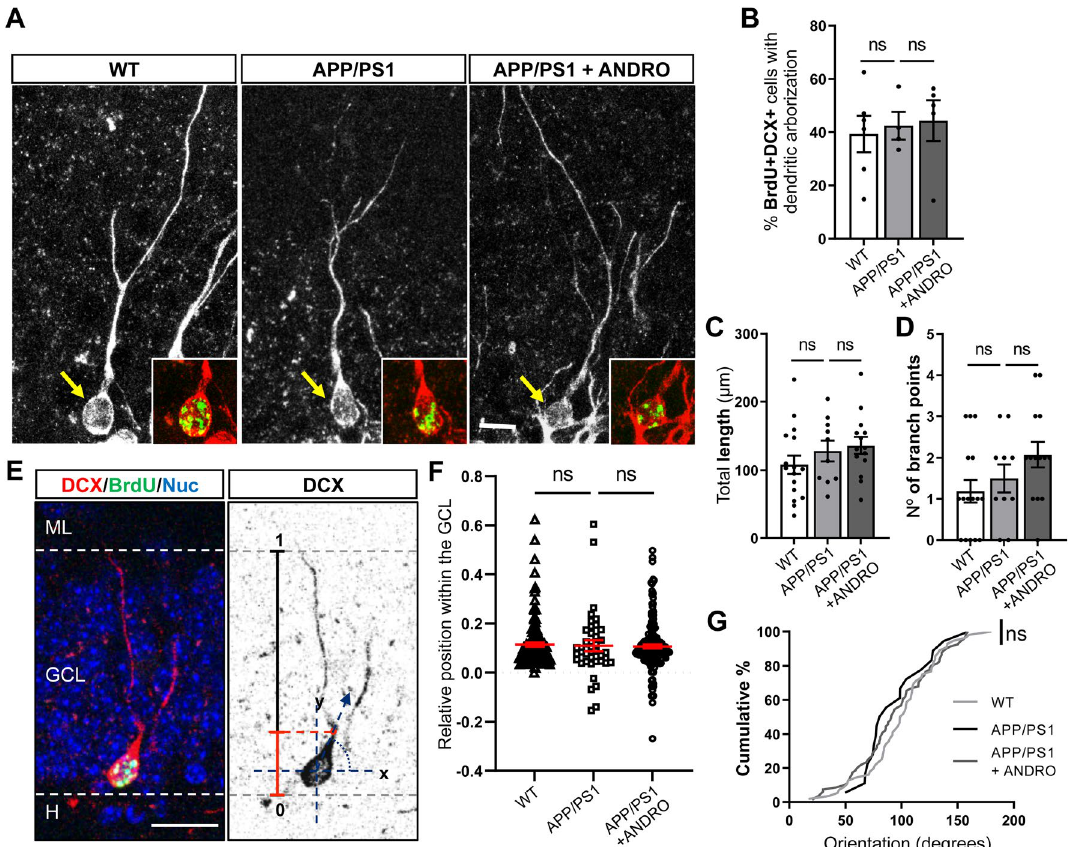
Figure 4. ANDRO does not affect early morphological development of newborn neurons. ( A ) Representative confocal images of BrdU+DCX+ cells showing dendritic arborization into the GCL towards the molecular layer in control wild-type (WT), APPswe/PSEN1ΔE9 (APP/PS1) mice, and APP/PS1 mice treated with ANDRO. Images correspond to maximal projection of 10 µm z-stack. Insets show z-stack of BrdU+DCX+ staining in cells indicated with the arrows (DCX: red; BrdU: green). Scale Bar: 10 µm ( B ) Quantification of the percentage of BrdU+DCX+ cells extending dendrites toward the molecular layer in WT, APP/PS1 mice and APP/PS1 mice treated with ANDRO. Data are presented as mean ± SEM; WT = 6 mice; APP/PS1 = 4 mice; APP/PS1 + ANDRO = 5 mice. ns, non-significantly different; one-way ANOVA test followed by Bonferroni post-hoc test. ( C , D ) Quantification of the total dendritic length ( C ) and number of branch points ( D ) of BrdU+DCX+ cells in WT, APP/PS1 and APP/PS1 mice treated with ANDRO. Data are presented as mean ± SEM; WT = 16 cells (N = 3 mice); APP/PS1 = 10 cells (N = 3 mice); APP/PS1 + ANDRO = 14 cells (N = 3 mice). One-way ANOVA test followed by Bonferroni post-hoc test. ns, non-significant. ( E ) Representative immunofluorescence of BrdU+DCX+ cell (left panel) and inverted DCX immunostaining (right panel) showing the schematic model of the analysis to assess the relative position of BrdU+DCX+ cells within the GCL, and the angular orientation of the initiation site (red dot), with the x-axis parallel to the GCL (0°–180°), the y axis pointing toward the hilus or ML (90° and 270°), and the origin at the center of the soma. ( F ) Quantification of the relative position of BrdU+DCX+ cells within the GCL. ns, non-significant, Mann–Whitney test. ( G ) Cumulative distribution plots of the angular orientation of the initiation site of BrdU+DCX+ cells. ns,